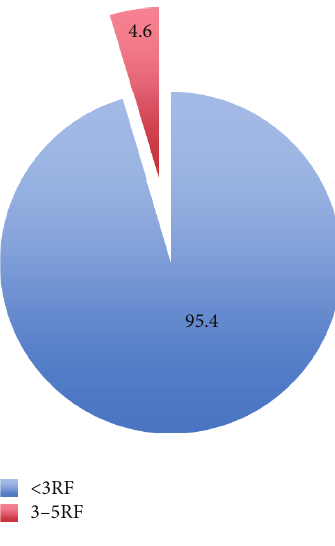
Figure 2: The distribution of composite cardiovascular disease risk factors among the participants